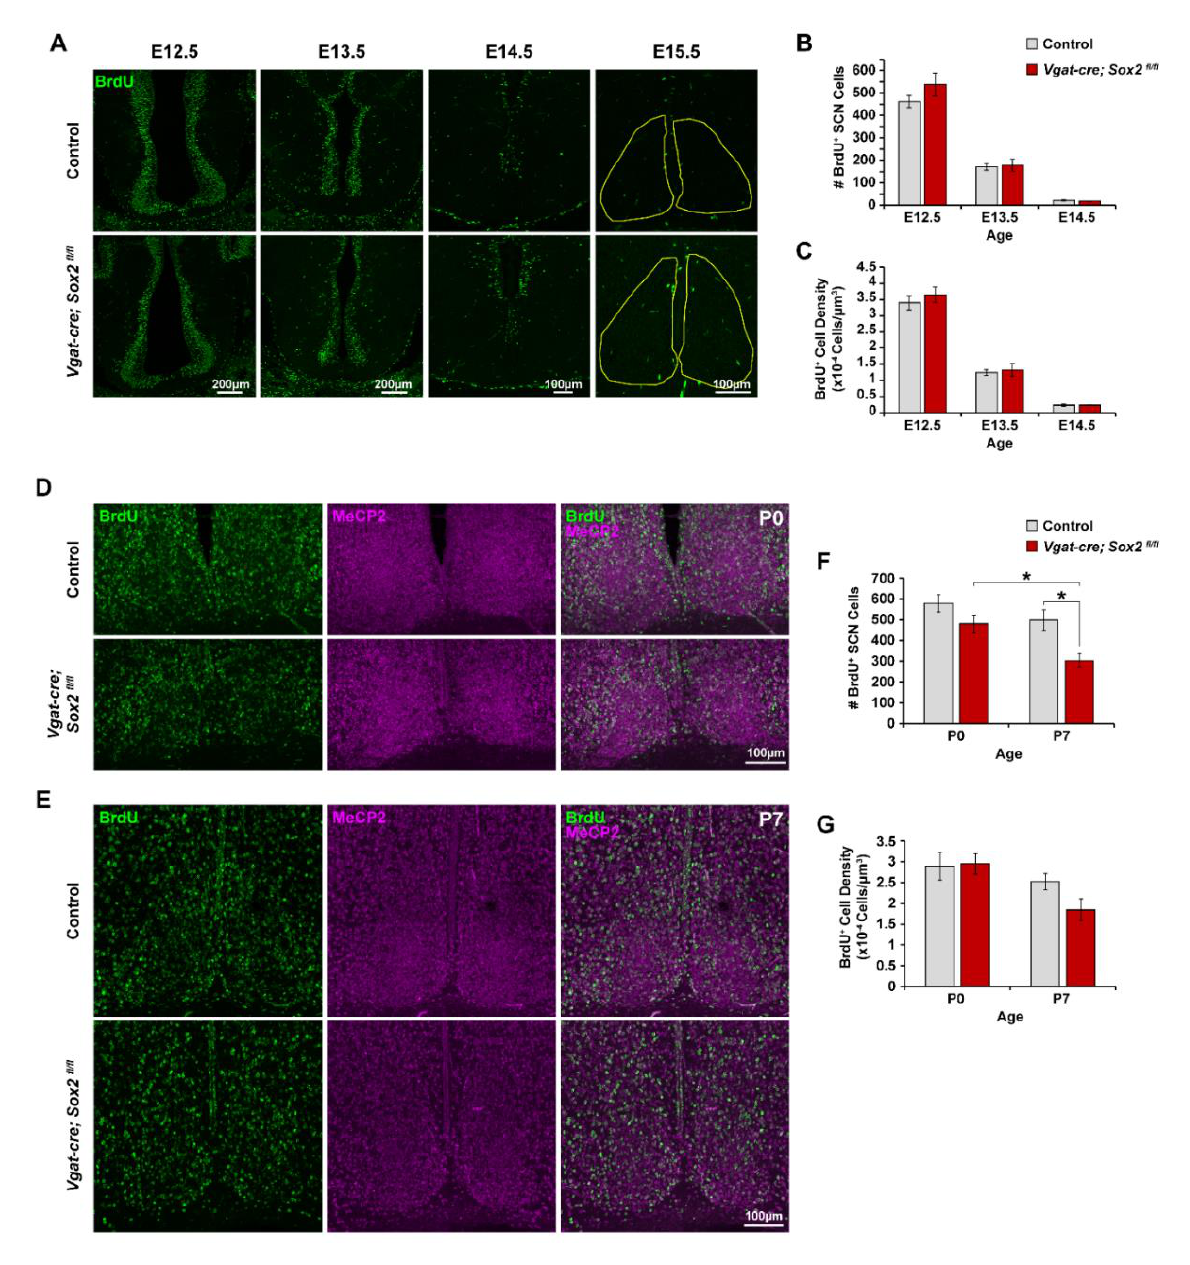
Figure 3. Vgat-cre;Sox2 fl/fl mice exhibit normal cell proliferation during SCN neurogenesis, but fewer newborn neurons survive in the postnatal SCN. ( A ) Representative photomicrographs of BrdU immunoreactivity (green) in the ventral anterior hypothalamus or SCN of control and Vgat-cre;Sox2 fl/fl mice at E12.5, E13.5, E14.5, and E15.5. ( B ) Number of BrdU + cells in the ventral anterior hypothalamus of control and Sox2 cKO embryos at E12.5, E13.5, and E14.5. ( C ) Quantification of BrdU + cell density in the ventral anterior hypothalamus at E12.5, E13.5, and E14.5. ( D , E ) Representative photomicrographs of BrdU (green) and MeCP2 (magenta) immunoreactivity in the ( D ) P0 and ( E ) P7 SCN of control and Vgat-cre;Sox2 fl/fl animals that had received daily pulses of BrdU from E12.5 to E15.5. ( F , G ) Quantification of ( F ) number and ( G ) density of BrdU + cells in the P0 and P7 SCN. Values represent mean ± SEM. * p < 0.05, two-way ANOVA with Tukey HSD. See Table 1 for the number of animals and litters